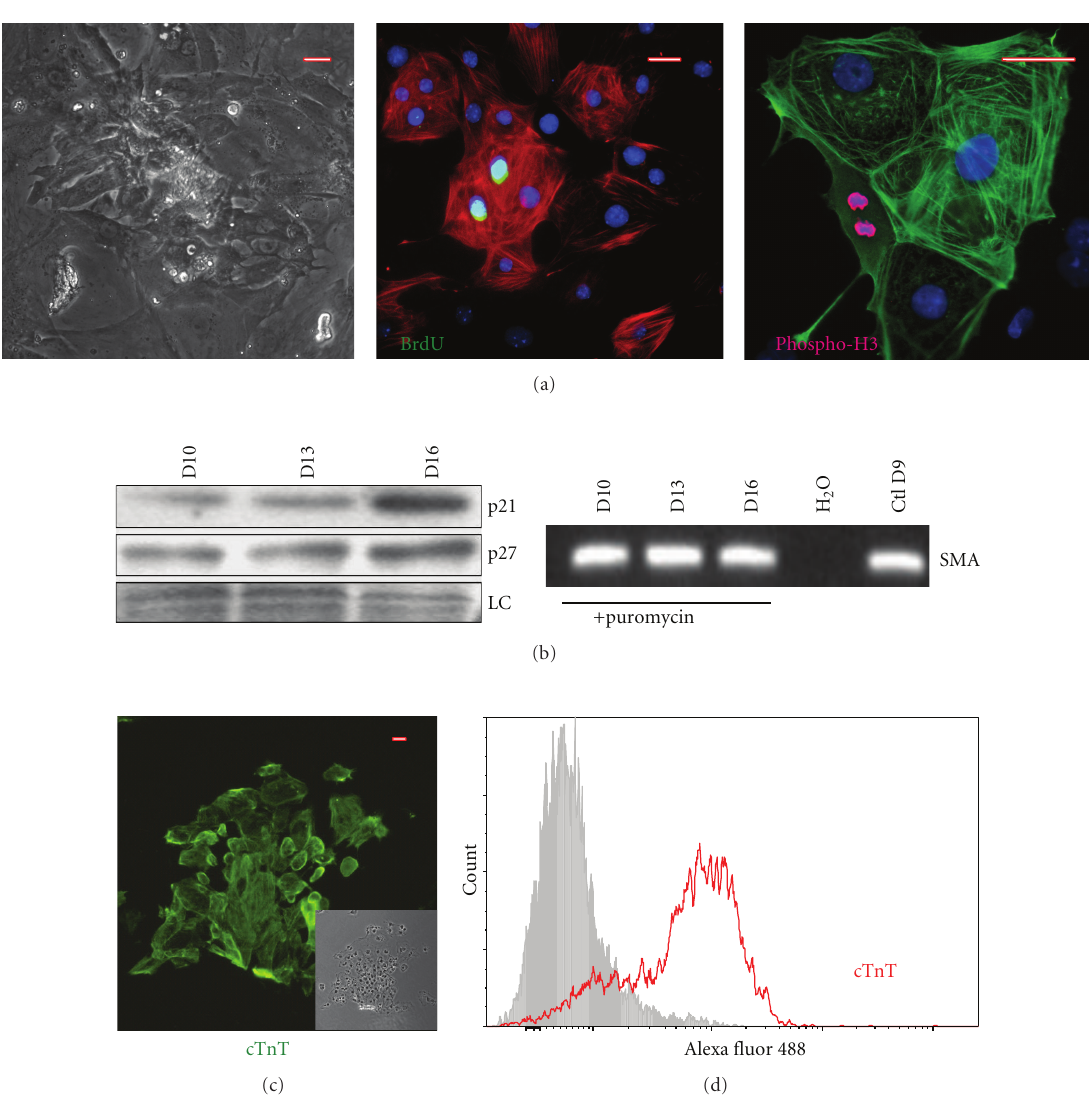
Figure 1: Characterization of syNP4 ES cell derived-CMs. (a) Traits of ESC-CM generated using the hanging drop technique. Following di ff erentiation and plating, puromycin-resistant cells aggregate in clusters and show spontaneous contractions. Day 8-9 CMs (one or two days after plating) readily incorporate BrdU (green) and dividing cells can be readily identified by the use of an antibody against a phosphorylated form of histone H3. (b) As a function of di ff erentiation time, syNP4 derived-CMs begin to express p21 CIP and p27 KIP1 markers of contact inhibition and cell cycle checkpoint control, but the cells also continue to express transcripts to α -smooth muscle actin ( α -SMA), a marker of immature cardiomyocytes. (c) Using the mass culture system, plated puromycin-resistant syNP4-derived CMs cluster similarly to that described in 1A above (see inset). Cells were immunostained with an antibody against cardiac TnT (cTnT), demonstrating that these clusters consist of CMs. (d) By flow cytometry, the purity of the cells has been determined to range from 75 to 92% ( n = 5), depending on the cultivation and selection conditions. LC: loading control. Size markers = 50 μ